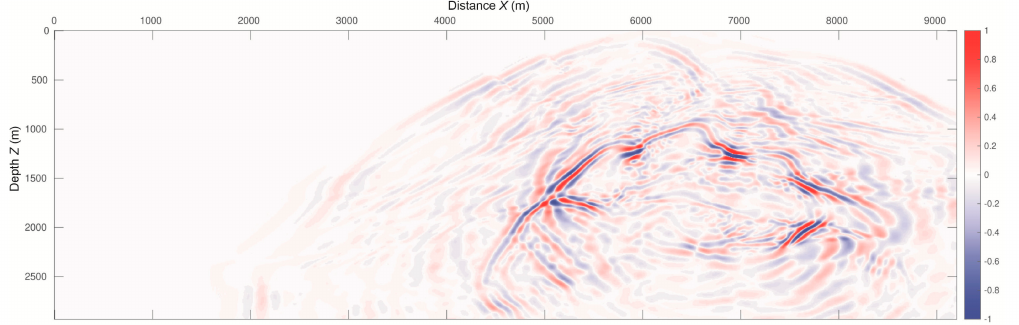
Figure 6. Snapshots computed after a 1 s simulation of the elastic wave equation in the two-dimensional Marmousi model. The visualization was made using the normalized and enhanced value of component v x .